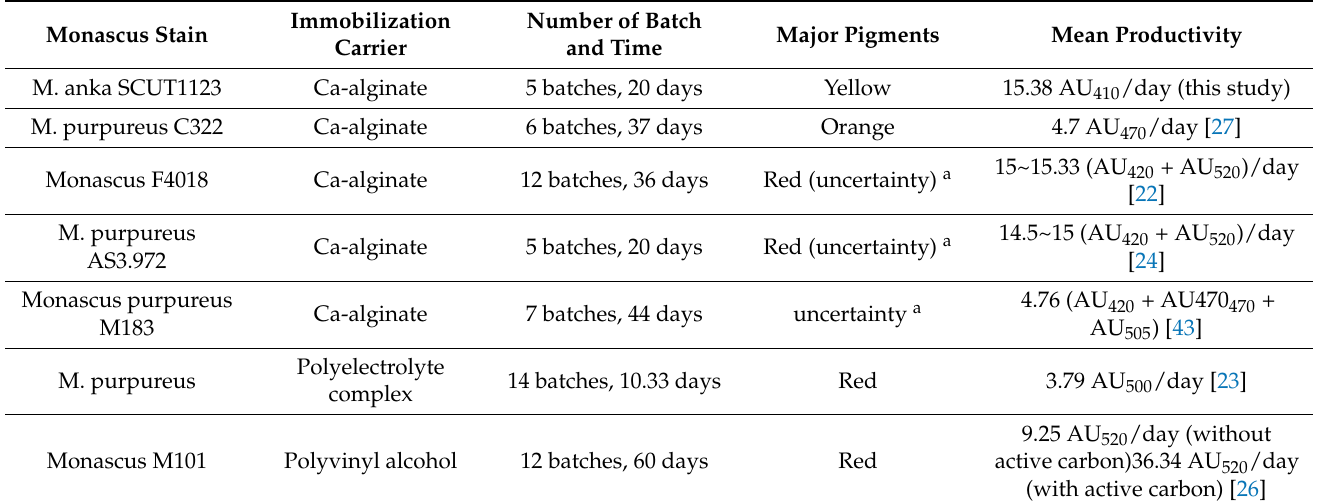
Table 3. Comparison of repeated-batch fermentation for Monascus pigments with immobilized